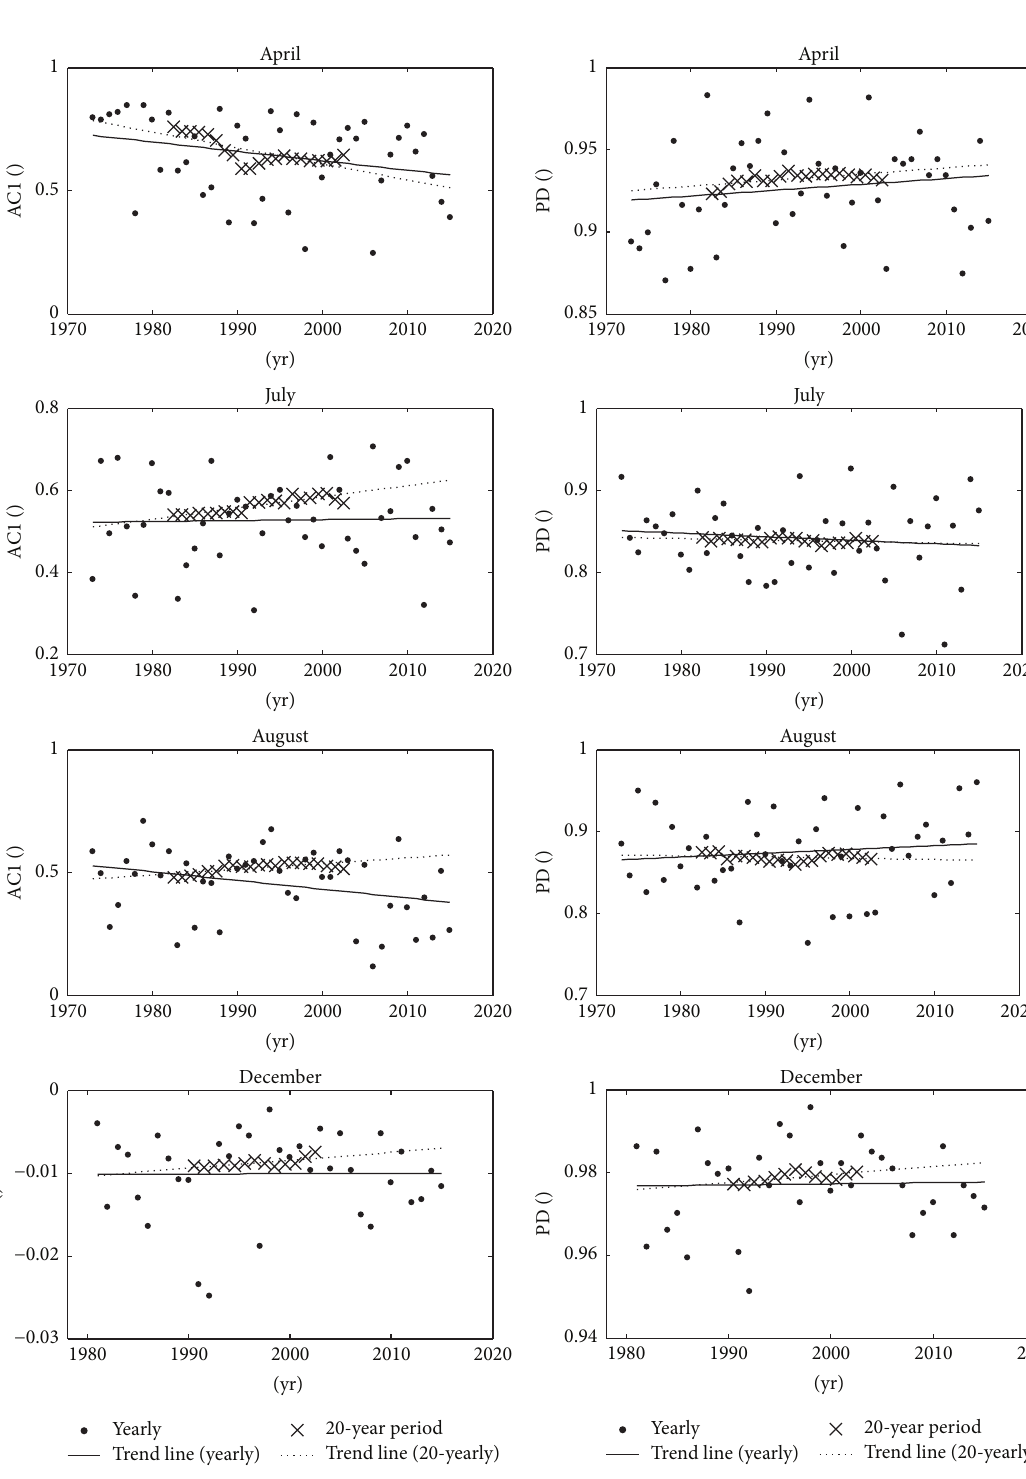
Figure 4: Temporal variation of yearly (dots) and 20-yearly (crosses) 1-hour precipitation lag-1 autocorrelation (AC1) and probability of dryness (PD) observed in Seoul. Linear trend lines of yearly (solid line) and 20-yearly (dotted line) 1-hour precipitation lag-1 autocorrelation and probability of dryness are shown